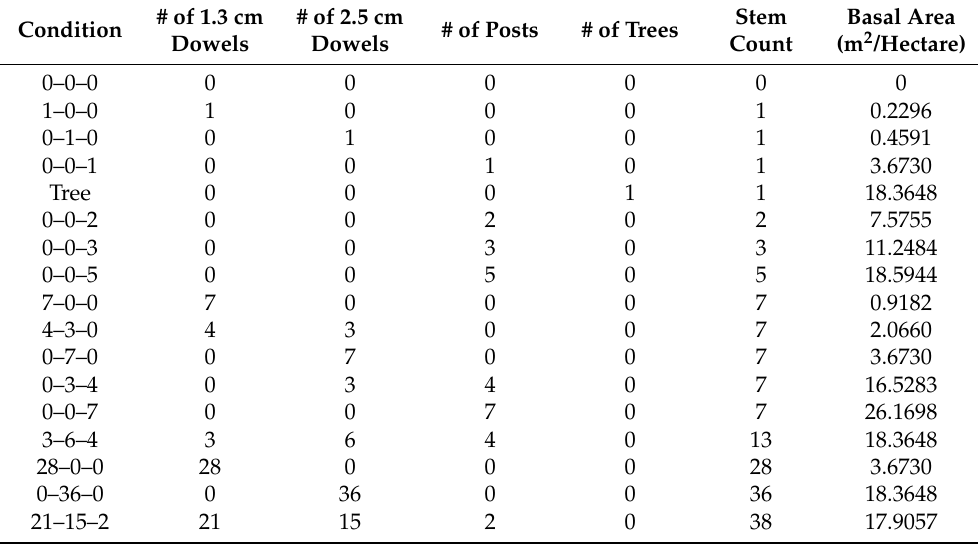
Table 1. Experimental arrangements of 1.3 cm and 2.5 cm diameter wood dowels, wood fence posts (7.0 cm × 10.2 cm), and a simulated tree made from attaching multiple posts together in a rounded shape to model varying levels of stem density (stem count) and basal area. Each dowel and post was 122 cm in height and mounted on a 107 cm × 121.9 cm pallet wood base between our acoustic emitter and our acoustic receivers, Blacksburg, VA,